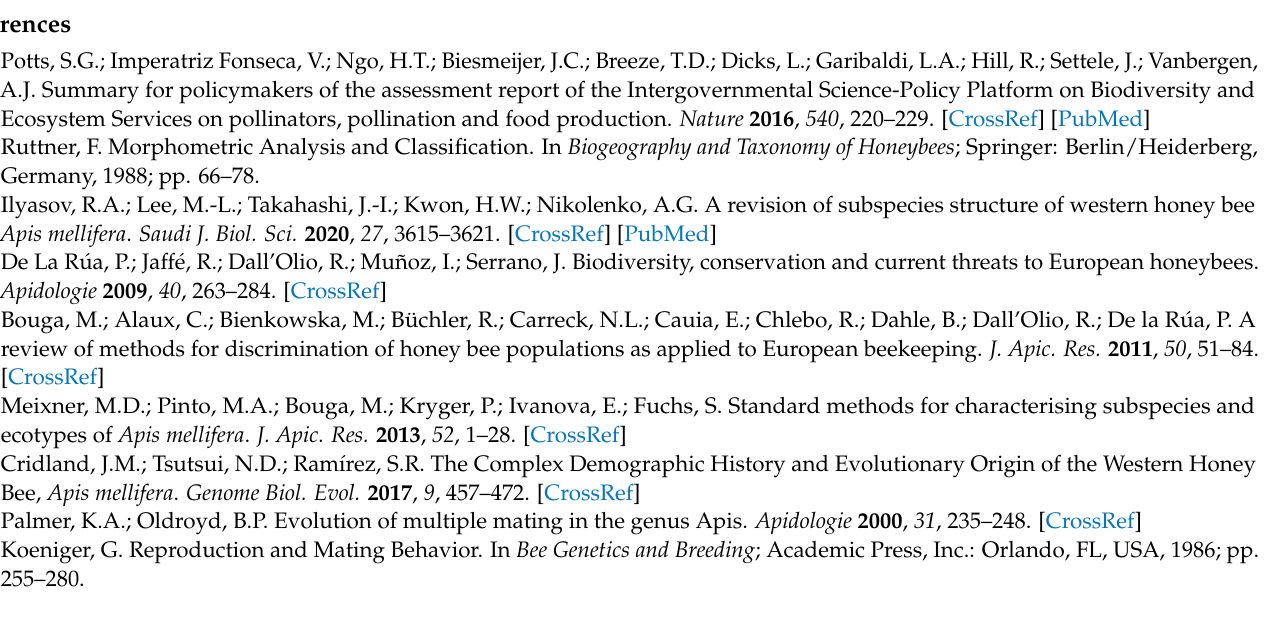
Table S9: Correlations between the positioning of the populations in the MDS and PCA plots with the geographical centroids of the countries from which the analyzed populations